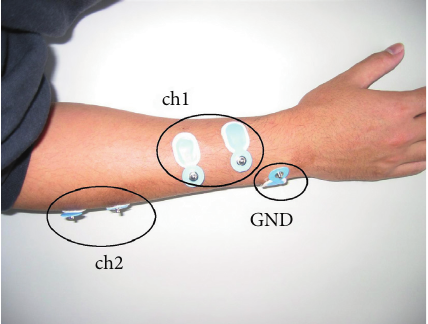
Figure 4: Positions of the surface electrodes ch1 and ch2 to measure EMG1 and EMG2 signals,